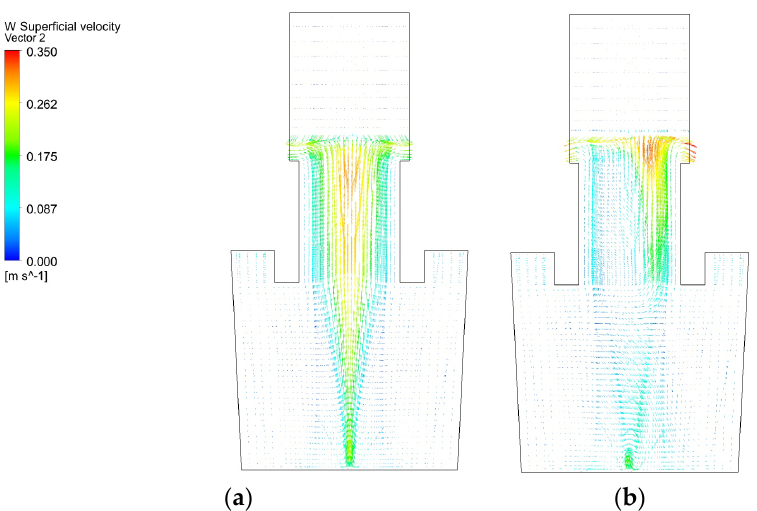
Figure 3. Superficial velocity vector diagram at Z = 0 plane with a flow rate of 900 NL/h: ( a ) With PBM; ( b ) Without PBM.